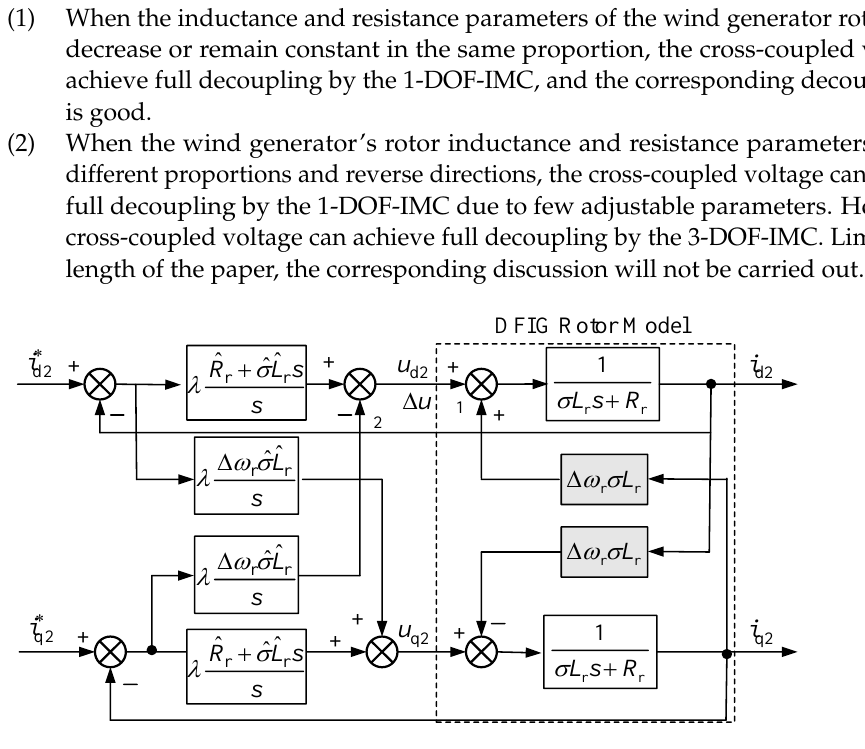
Figure 7. The block diagram of 1-DOF-IMC decoupling for DFIG. * means the reference value.